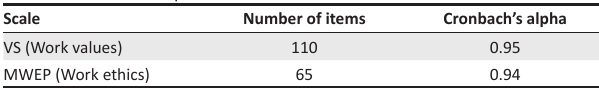
TABLE 1: Cronbach’s alpha coefficients for the scales.